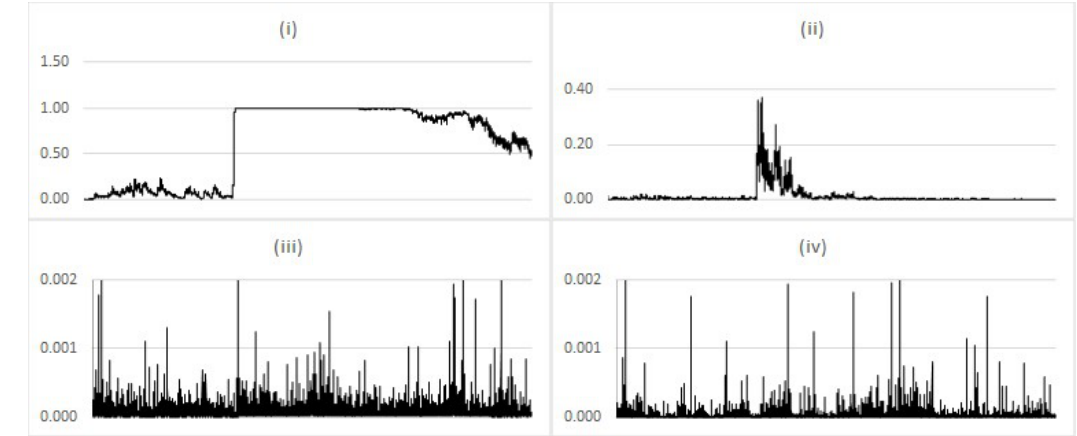
Figure 4. Probability mass shifted beyond the 5% quantile on the edge of the posterior with regime change after 10,000 steps, using the Liu and West filter with additional noise term φ equal to ( i ) 0.1